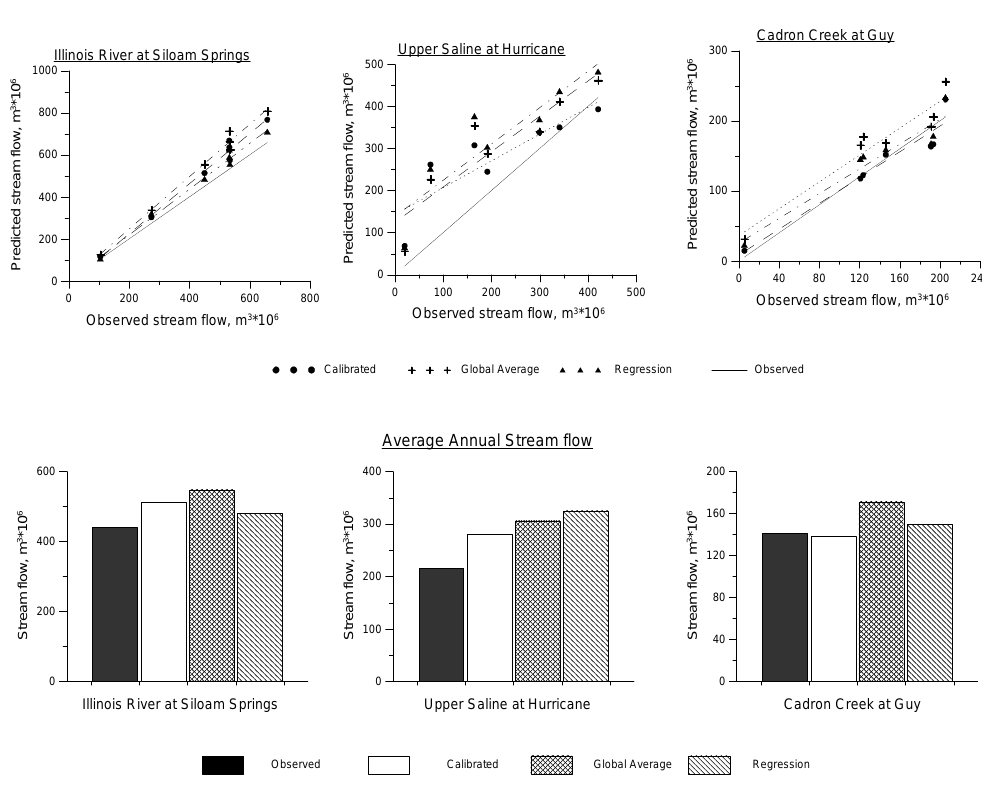
Figure 6 Scatter plots for annual stream flow volumes for the period October 1998 to September 2004 (top) and comparison of average annual volumes (bottom) as obtained using the various regionalization